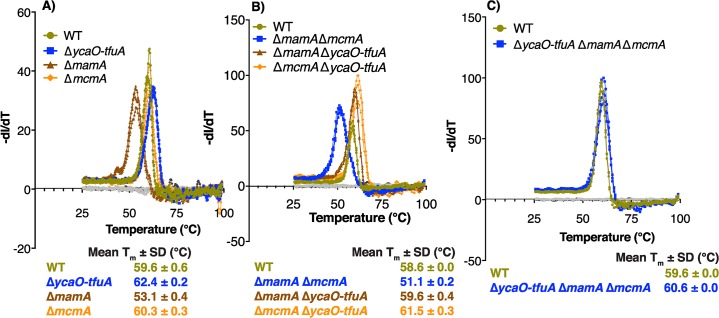
Tm of the MCR complex.The thermal stability of the tandem-affinity-tagged MCR complex purified from (A) WT and single mutants lacking ycaO-tfuA, mcmA, or mamA; (B) WT and double mutants lacking two of ycaO-tfuA, mcmA, and mamA in all possible combinations; and (C) WT and the triple mutant lacking ycaO-tfuA, mcmA, and mamA was measured using the SYPRO Orange dye–based Thermofluor assay. The inflection point of the first differential curve for the fluorescence intensity relative to the temperature (−dI/dT) for each of three technical replicates was used to calculate the mean Tm ± standard deviation (in°C) of the MCR complex. The no-dye control (in gray) lacks the SYPRO Orange dye, and the no-protein control (in black) was performed with elution buffer instead of purified protein. The assays reported in each panel were conducted on the same day with freshly purified protein using the WT as a control. Slight variations from day to day in the control are due to variations in the individual protein preparations. The primary data used to construct this figure are provided in S14 Table. mamA, methylarginine modification; mcmA, methylcysteine modification; MCR, methyl-coenzyme M reductase; Tm, melting temperature; WT, wild-type.